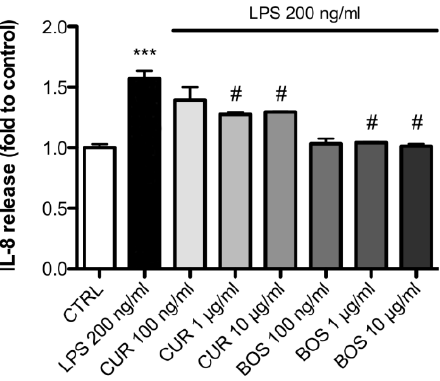
Figure 2. IL-8 release in PBMC after 24 h of LPS stimulation (200 ng/mL); cells were preincubated with CUR and BOS for 24 h. *** p < 0.001 vs. control; # p < 0.05 vs. stimulus.